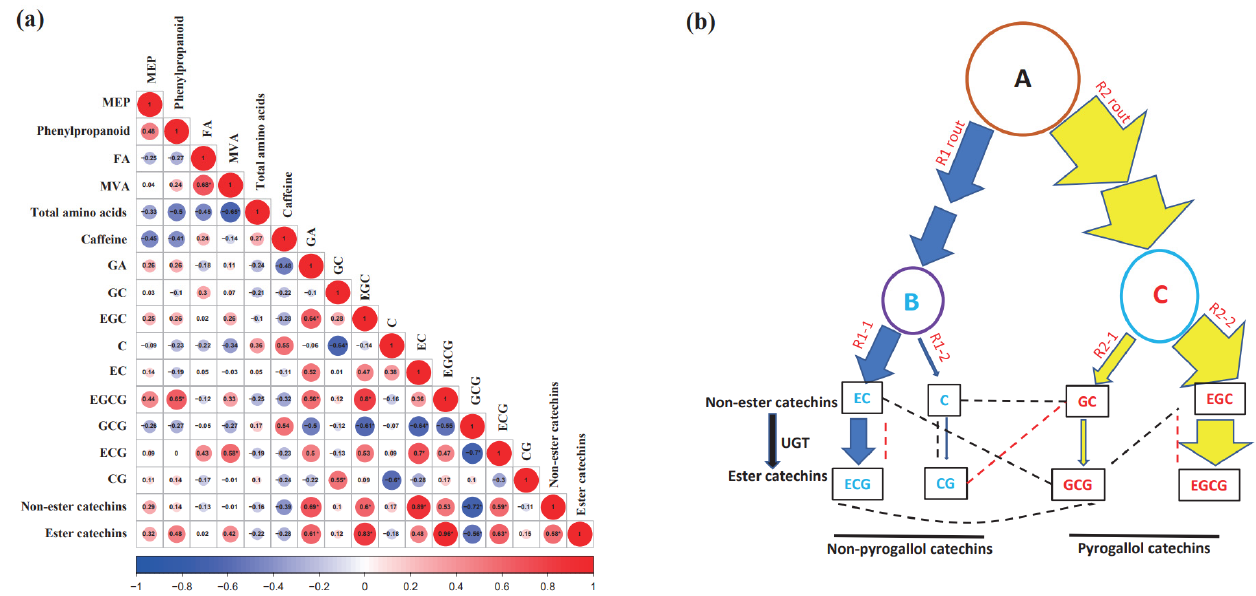
Figure 2. The correlations among the non-volatile metabolites and the four volatile synthesis pathways. ( a ) The correlations among total volatiles originating from four individual pathways, total amino acids, caffeine, and various catechins. ( b ) The carbon flux of catechin synthesis pathways in Camellia sinensis cv Baijiguan and the correlations among various catechins. A: dihydrokaempferol; B: leucocyanidin; C: leucodelphinidin. The red dashed lines represent a significant positive correlation; the black dashed lines represent a significant negative correlation. Asterisk represent statistically